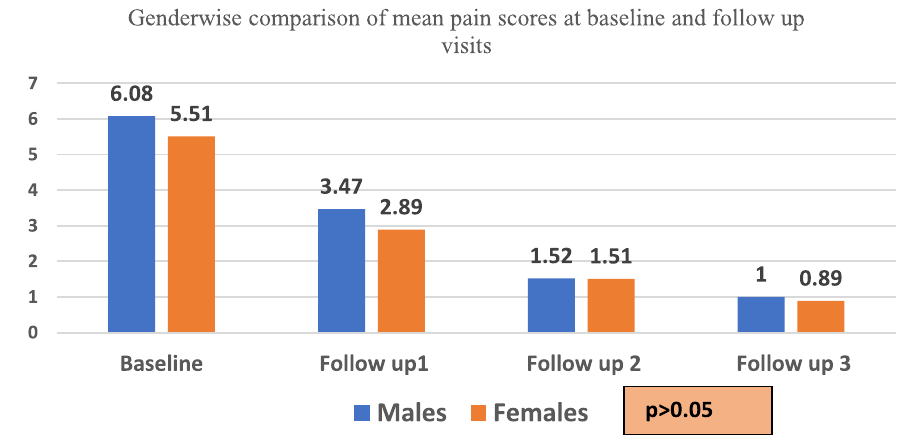
Fig. 2. Gender wise comparison of mean pain